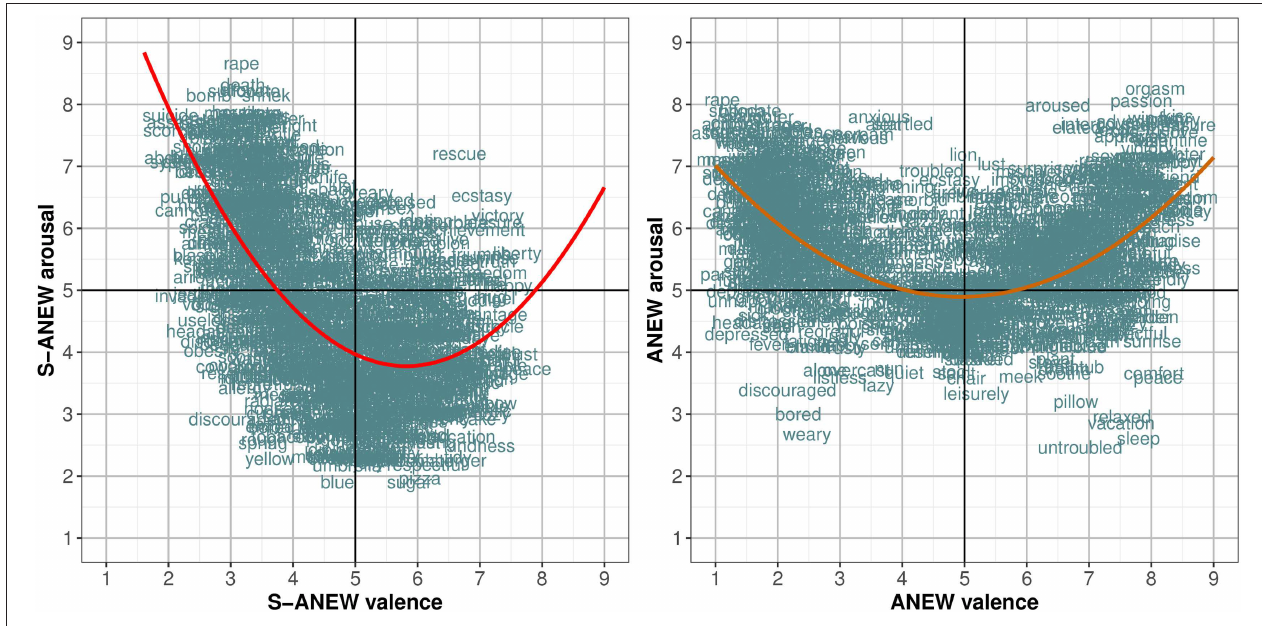
FIGURE 3 | Distribution of the mean values corresponding to the suspense ratings of the 1,034 words in the dimensions of valence and